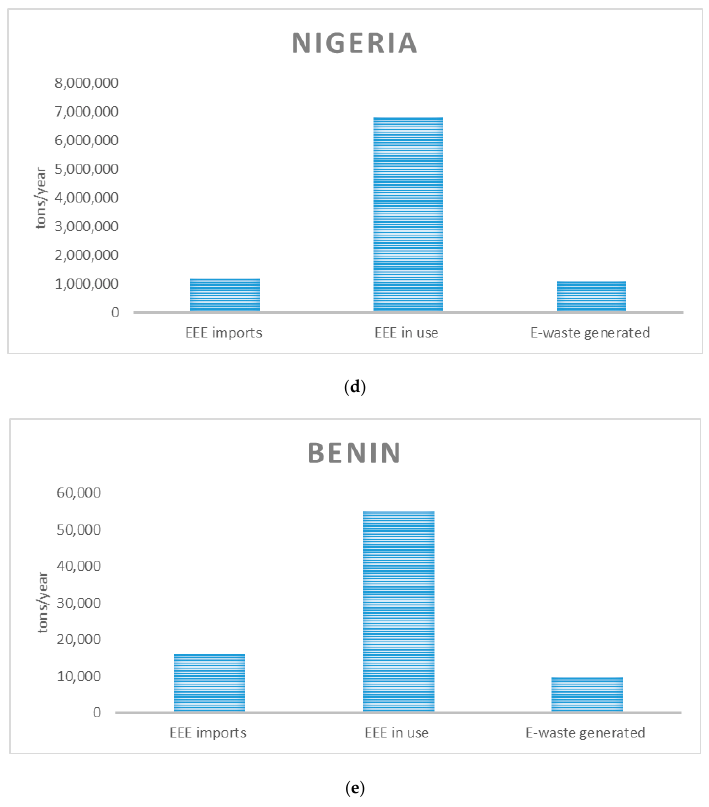
Figure 2. Statistics on electronic waste in West African countries. ( a ) Ghana, ( b ) Liberia, ( c ) Cote d’Ivoire ( d ) Nigeria ( e ) Benin. Source: [25,26] This influx of electronic materials, which is eventually converted to e-waste, is a result of weak legislation on e-waste control in African nations. Studies have shown that there is little legislation in Africa regarding the effective management of electronic waste [27,28]. Reviews by [25,29] have revealed that West Africa has the highest population of people covered by legislation on e-waste at about 53%, with Northern and Southern Africa having no data to show. Figure 3 shows the population of people in Africa covered by the law on e-waste disposal.